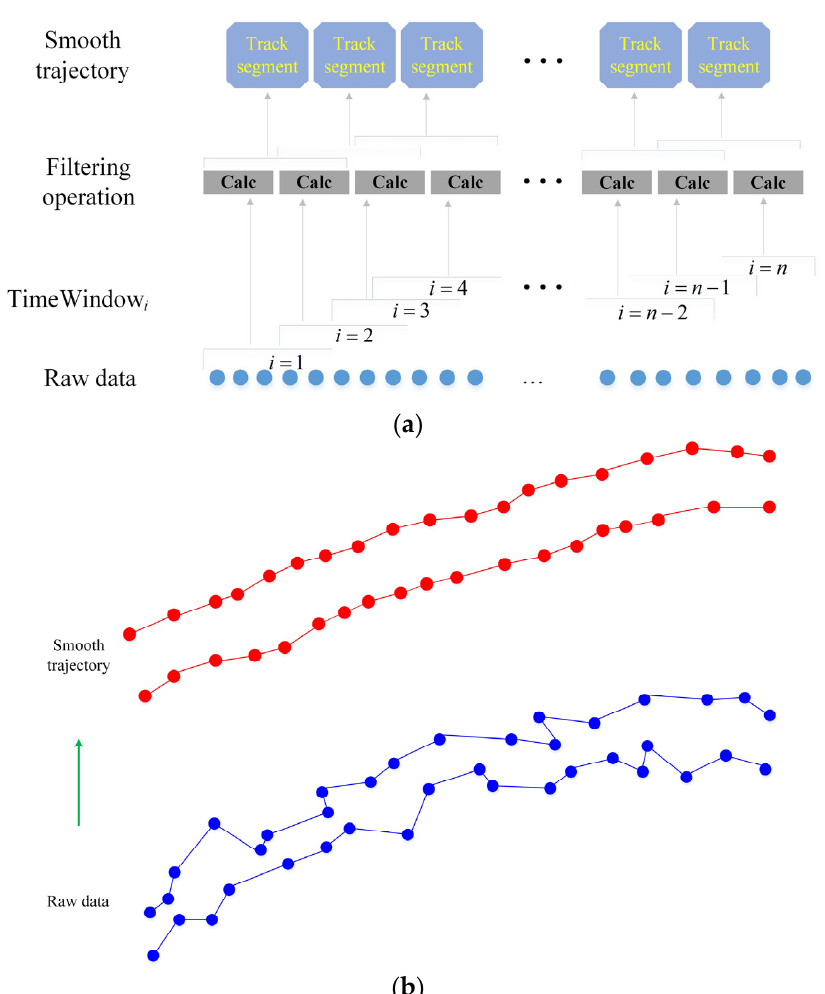
Figure 3. Time window panning and smoothing fi ltering schematic: ( a ) Schematic diagram of the trajectory fi ltering process ( b ) Diagram of trajectory fi ltering before and after.